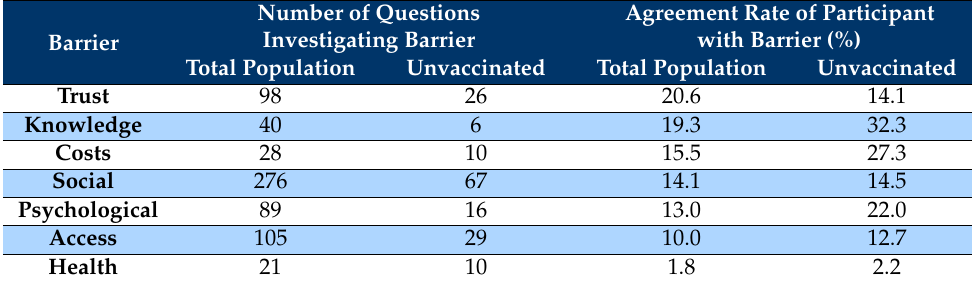
Table 4. Prevalence of barrier types reported by the included